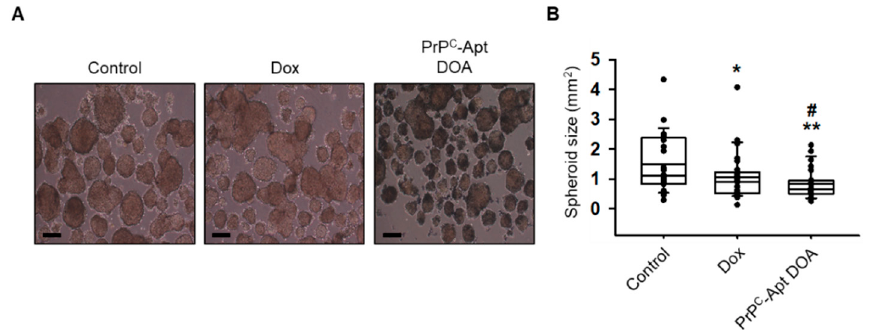
Figure 8. PrP C -Apt DOA efficiently inhibit the sphere formation capacity of CRC cells. ( A ) Sphere formation assay of SNU-C5 cells post treatment with free Dox or PrP C -Apt DOA ( n = 3). Scale bar: 200 µ m. ( B ) Diameters of the spheroids are shown in the graph. Dot symbols represent individual values. The values represent mean ± SEM. * p < 0.05, ** p < 0.01 vs. control; # p < 0.05 vs. free Dox.